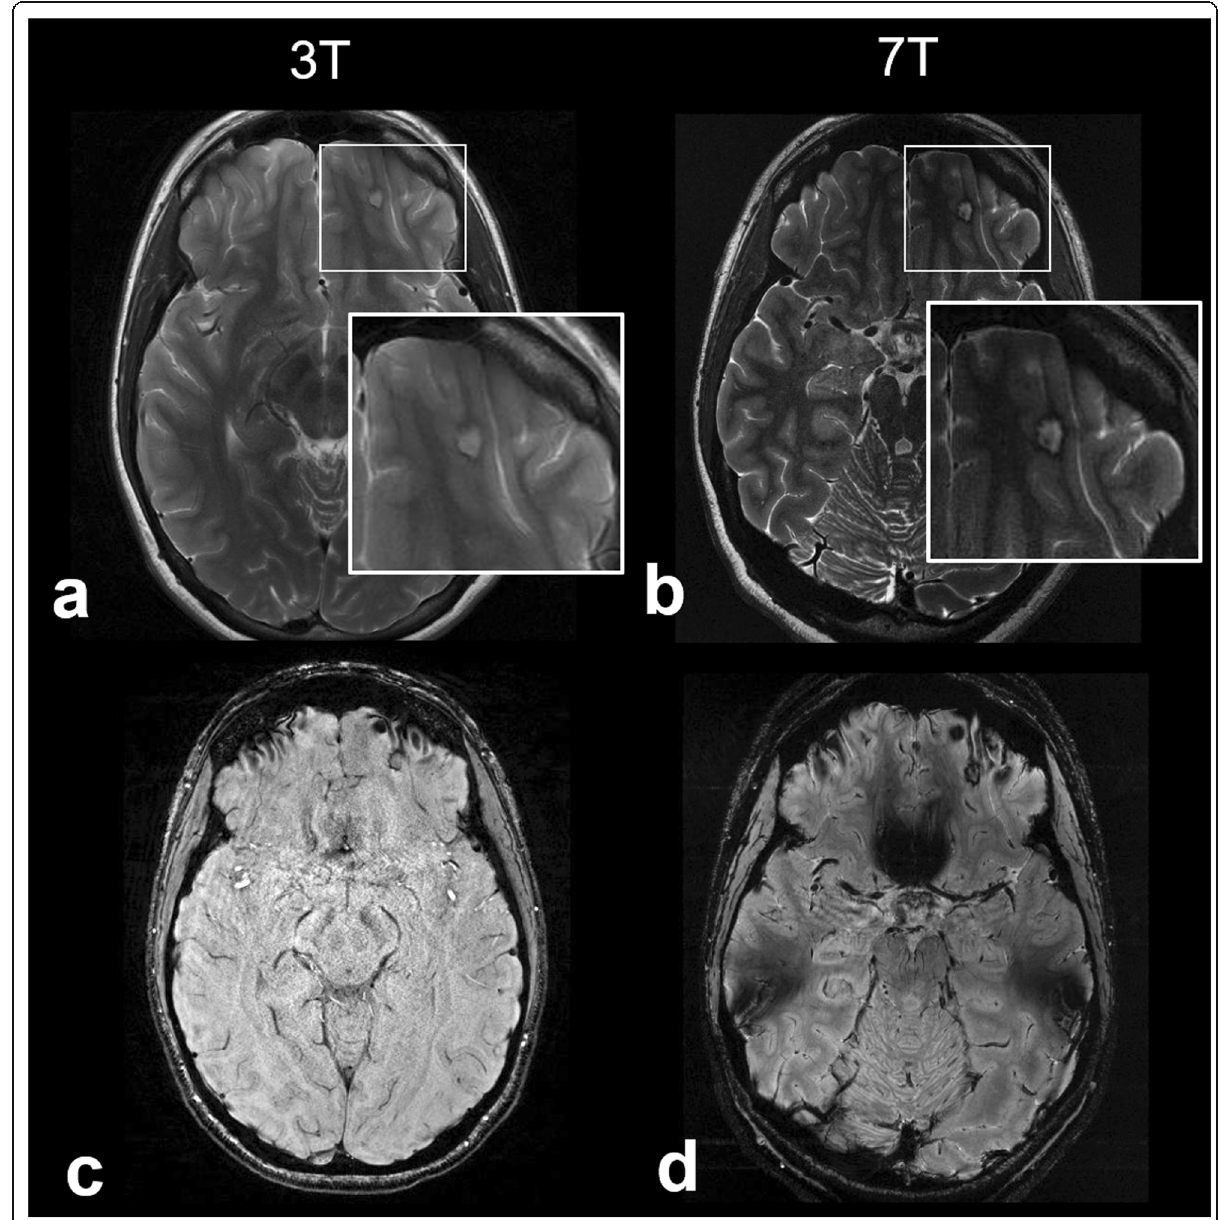
Fig. 3 Cavernous malformation on 3-T and 7-T magnetic resonance imaging. Axial T2-weighted images acquired at 3 T ( a ) and 7 T ( b ) show a 6- mm cortical lesion in the left orbitofrontal gyrus with central T2 hyperintensity and peripheral T2 hypointensity. Axial susceptibility-weighted images acquired at 3 T ( c ) and 7 T ( d ) show marked susceptibility effect within the rim of the lesion. The 7-T images have higher signal-to-noise ratio and better delineate the lesion compared to the 3-T images. The lesion was resected and found to be a cavernous malformation on